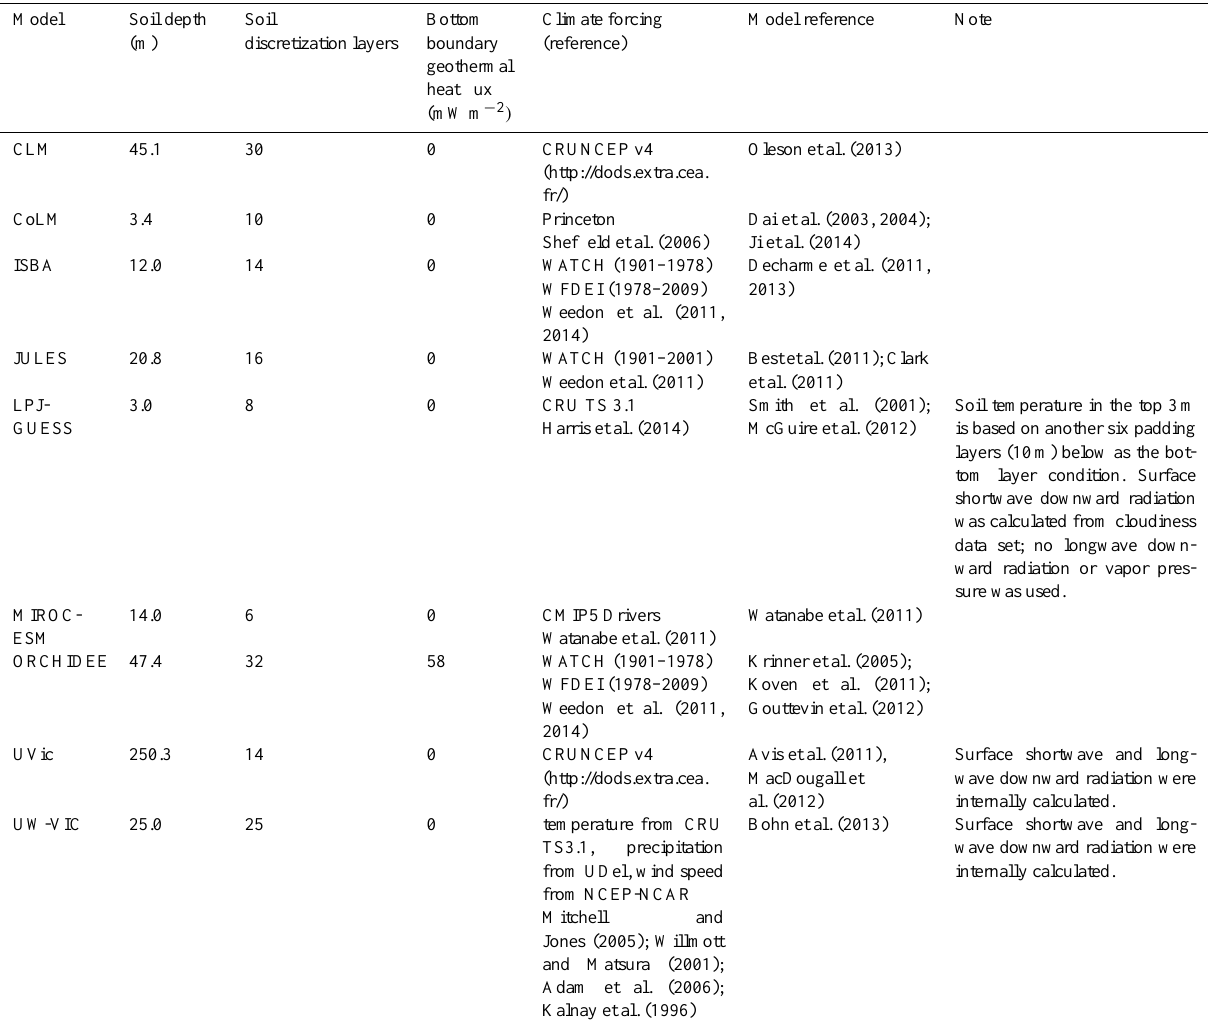
Table 1. Soil depth for soil thermal dynamics and climate forcing used in each model.